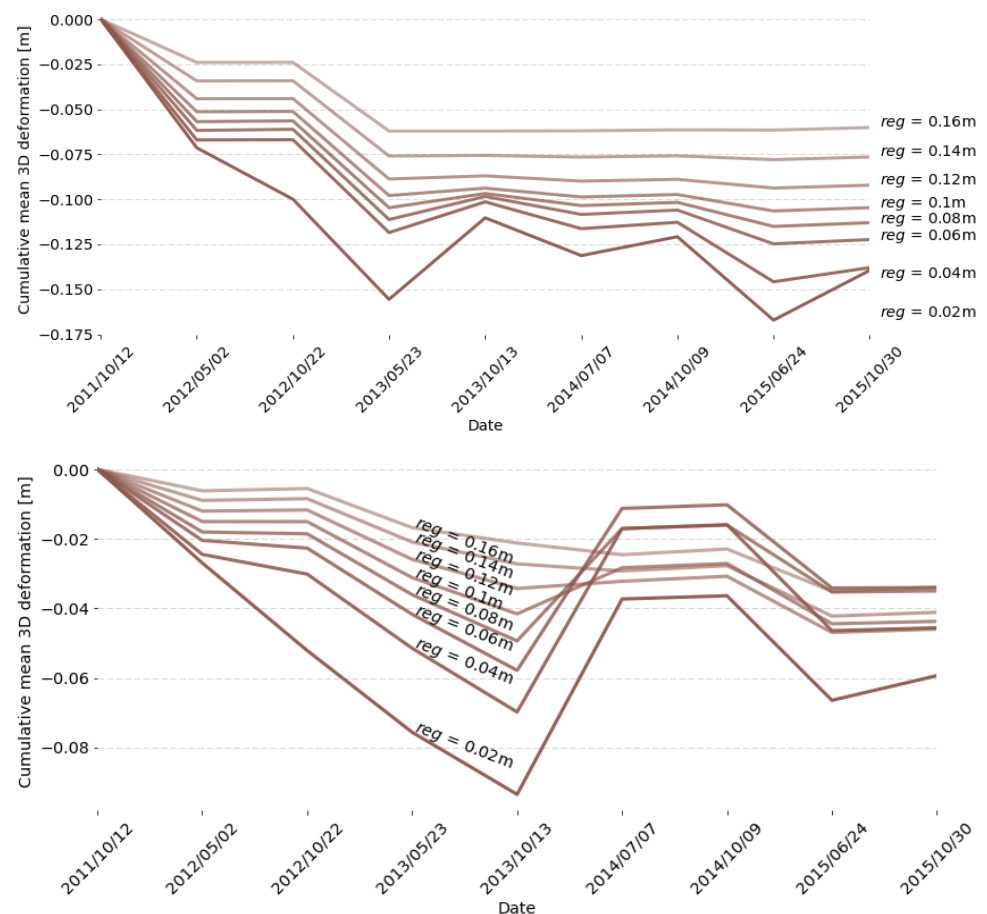
Figure 5. Cumulative mean 3D deformation of the ‘landslide scarp’ class for landslides L1 (top) and L2 (bottom), with different registration errors ( reg ) used for calculating the LOD 95 and, accordingly, filtering “real” change.